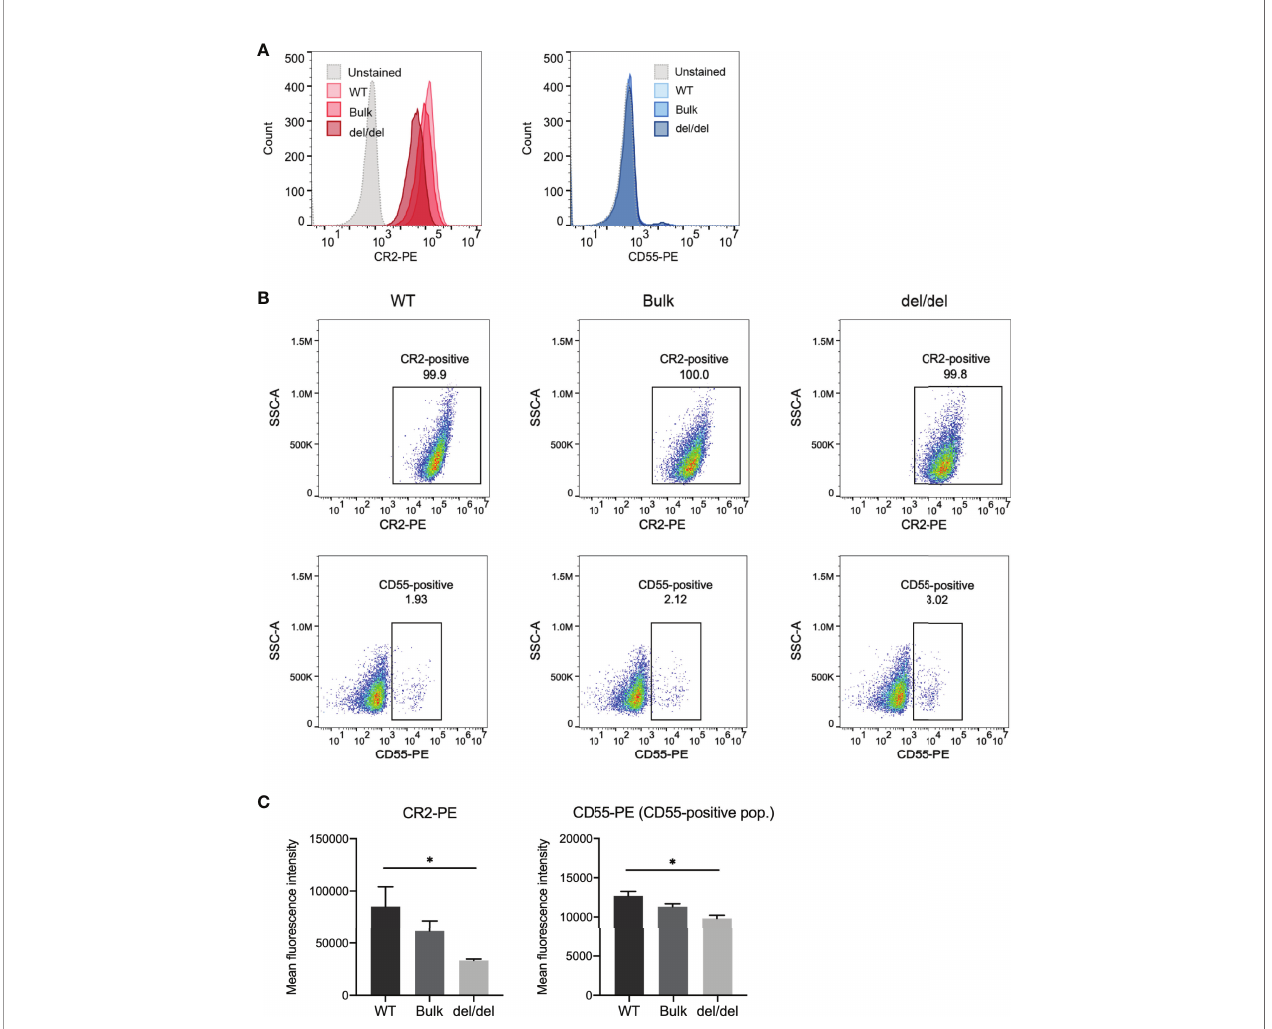
FIGURE 7 | CRISPR deletion of BEN-2 decreased surface expression of CR2 and CD55 in the Raji B cell line. (A) Cell surface expression of CR2 and CD55 protein was determined using fl ow cytometry. Cells were labelled with PE-conjugated CR2 antibody, PE-conjugated CD55 antibody or PE-conjugated IgG (isotype control) to con fi rm positive expression. Samples were run alongside unstained controls (not shown). For each sample, 10000 events were collected. Representative histograms from the WT, bulk and del/del samples stained with CR2-PE or CD55-PE, as well as unstained WT control. (B) Representative dot plot from the WT, bulk and del/del samples stained with CR2-PE or CD55-PE. The CR2- and CD55-positive gates were plotted using the unstained control. (C) Bars represent mean fl uorescence intensity ± SEM from 3 biological replicates. For CD55, the geometric mean of the CD55-positive population was assessed. Asterisks represent statistically signi fi cant differences between WT and del/del samples (* p <